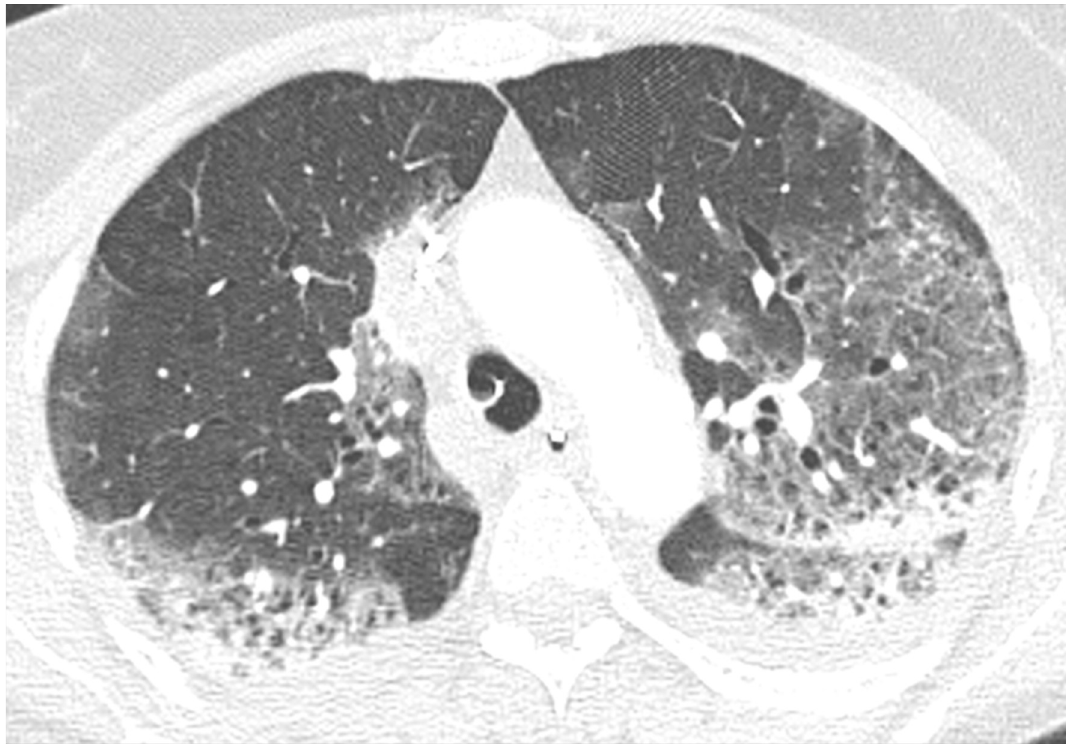
Fig 2. Crazy paving. Axial reconstruction of a CT in lung window demonstrating crazy paving.